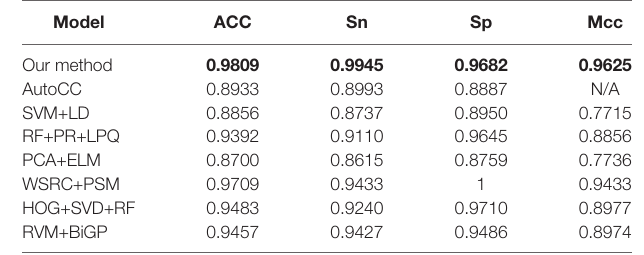
TABLE 4 | Comparing the prediction performance by the proposed method (FCTP-WSRC) and some state-of-art works on the H. pylori dataset. Model